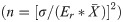
Minimum number of trees to be sampled using area under the flush shoot dynamics curve (AUFSD).Relative sampling error (Er) of the area under the flush shoot dynamics curve as a function of sample size. Each empty point represents one set of trees randomly selected (from a total of 20 sets) with n = 3, 6, 12, 24, 48 and 96 trees (A: west side; B: east side; C: average data from both sides). D: Optimum sample size (number of trees) needed to achieve a given Er
(n=[σ/(Er*X¯)]2) [3], by considering the area under the curve of new shoot number for mature ‘Valencia Late’ sweet orange trees grafted onto ‘Swingle’ citrumelo rootstock. A more flexible Er of 10% is indicated by the horizontal line.